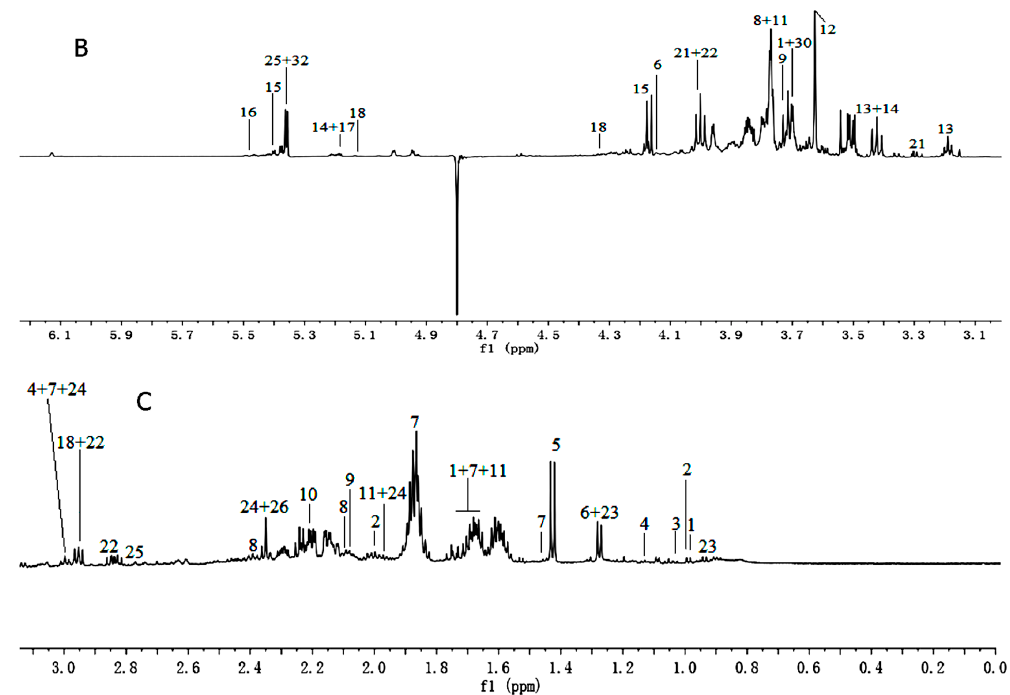
Figure 1. 1 H-NMR spectra (600 MHz) of aqueous methanol fractions in PR from JSJR in low field region ( A ); middle field region ( B ) and high field region ( C ). NMR solvent: CD 3 OD:KH 2 PO 4 buffer in D 2 O 1:1.